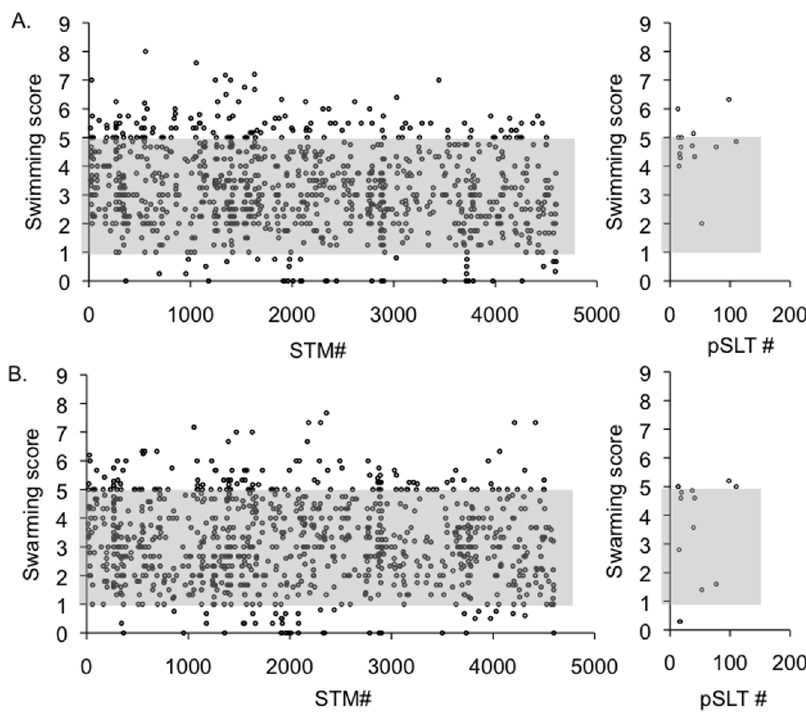
Figure 1. Motility scores of single deletion mutants of Salmonella Typhimurium ATCC14028 on swimming (A) and swarming (B) agar. Stationary phase cultures were transferred to motility agar, and motility was scored after 3.5 and 5 hours of incubation at 37 u C on swimming or swarming plates, respectively. Motility was scored on the scale from 0 to 10 with wild type motility equal to 5. Data are presented as average swimming or swarming score from experiments with triplicate samples, performed on three independent occasions. Dots located outside of shaded area indicate scores greater than 5.25 and lower than 1.25 to define mutants with increased or reduced ( , 25 % of wild type) motility. categories: (a) Mutants with defects in both types of motility; (b) Mutants with reduced swimming motility, swarming motility is unaffected; (c) Mutants reduced swarming motility only, swimming is unaffected; (d) Mutants that were hypermotile (Figure 2).